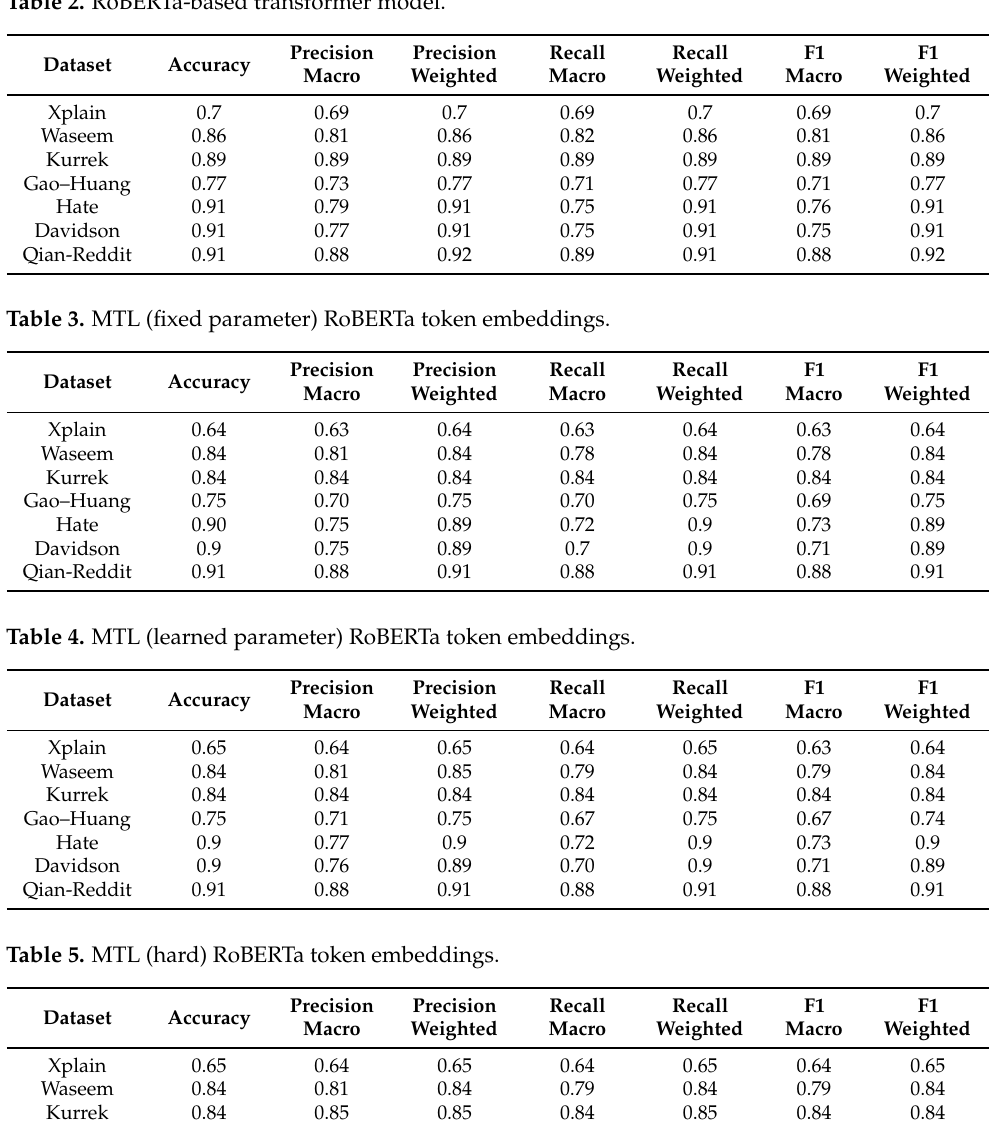
Table 2. RoBERTa-based transformer model.